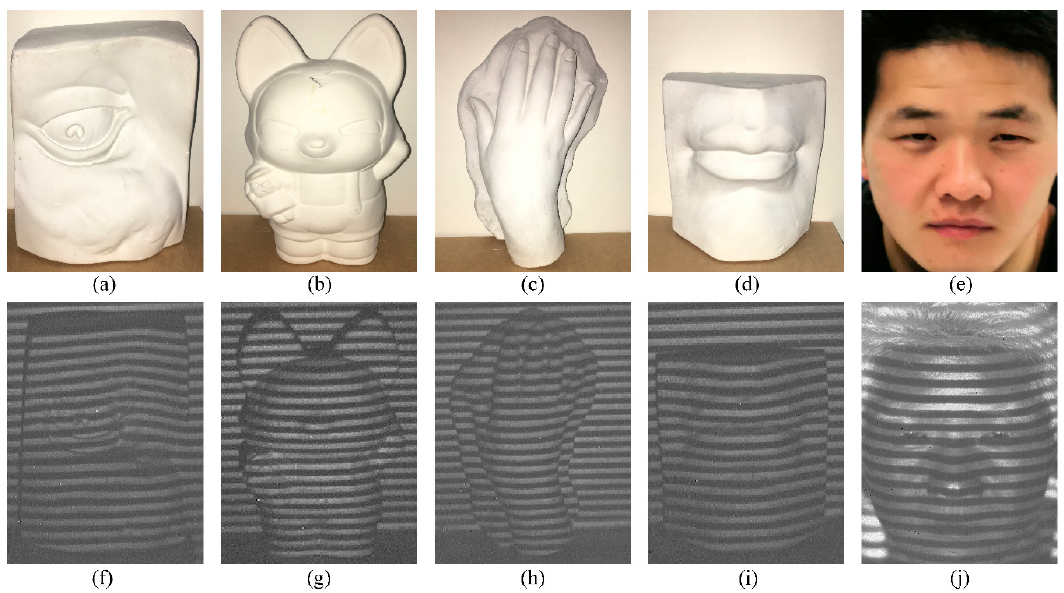
Figure 2. ( a ) Schematic of the three-dimensional (3D) shape reconstruction system. ( b ) Photograph of the 3D shape reconstruction system.